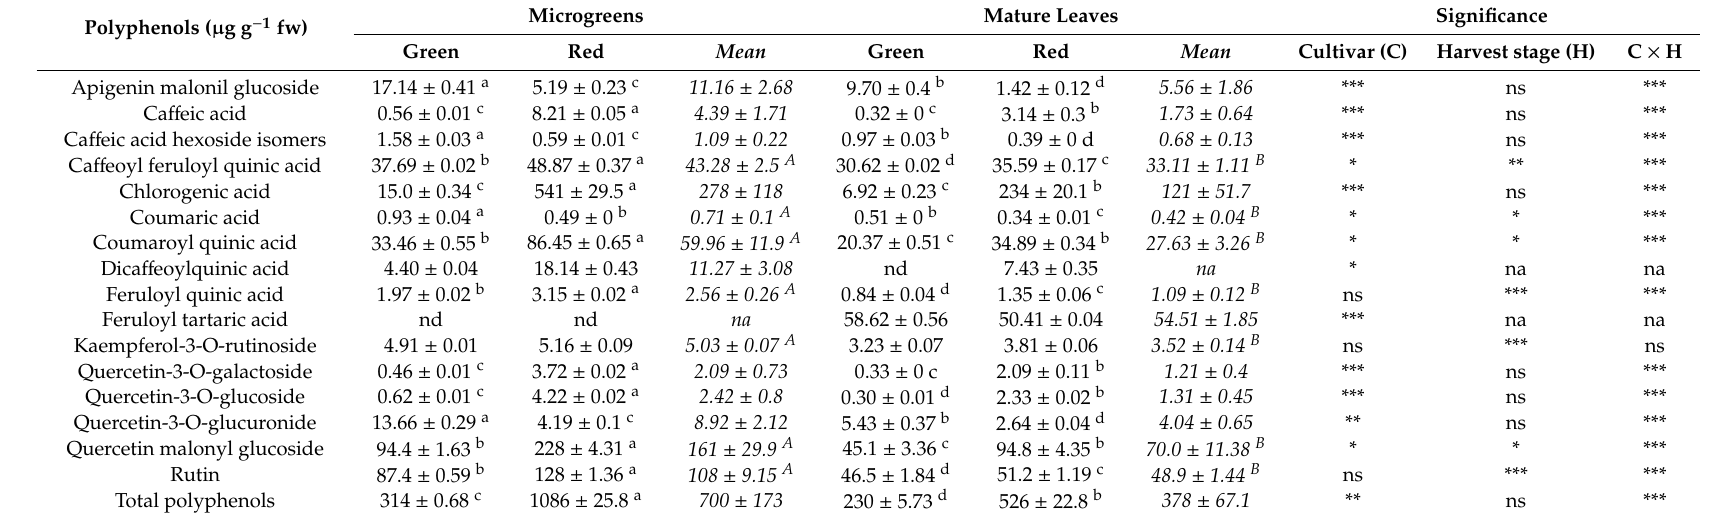
Table 4. Polyphenols content of green and red Salanova butterhead lettuce as influenced by harvest